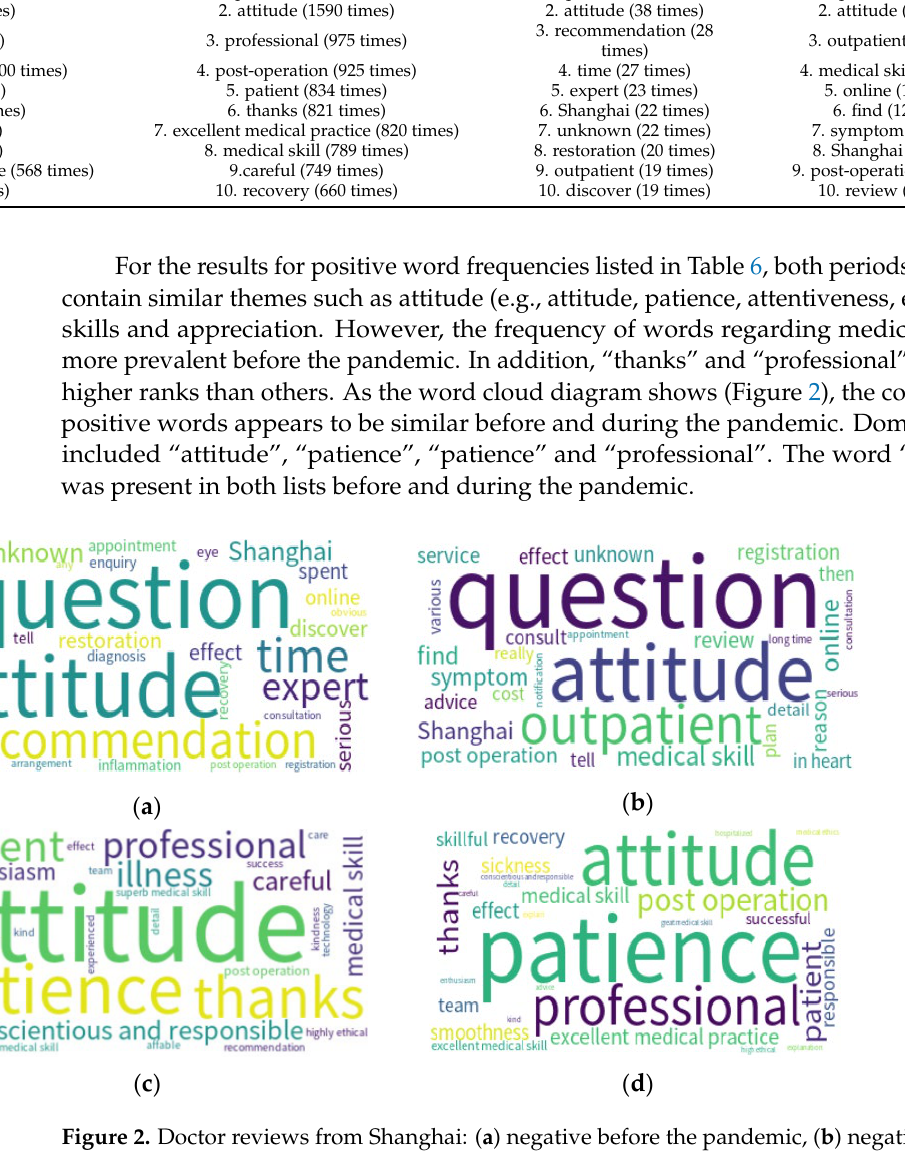
Table 7. Frequently Used Words in Comments (Hubei).